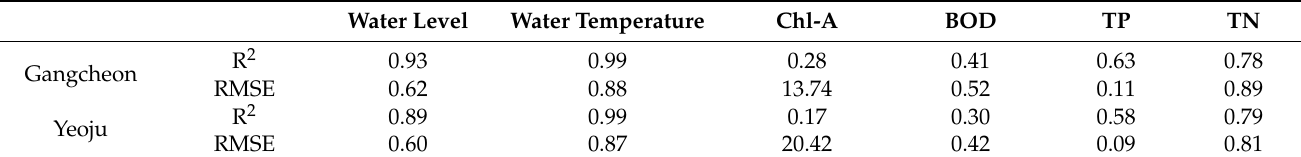
Table 3. Calibration result of EFDC-NIER.